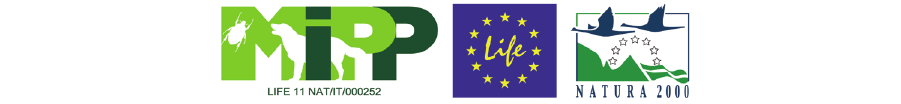
Mean number of captures per trap and